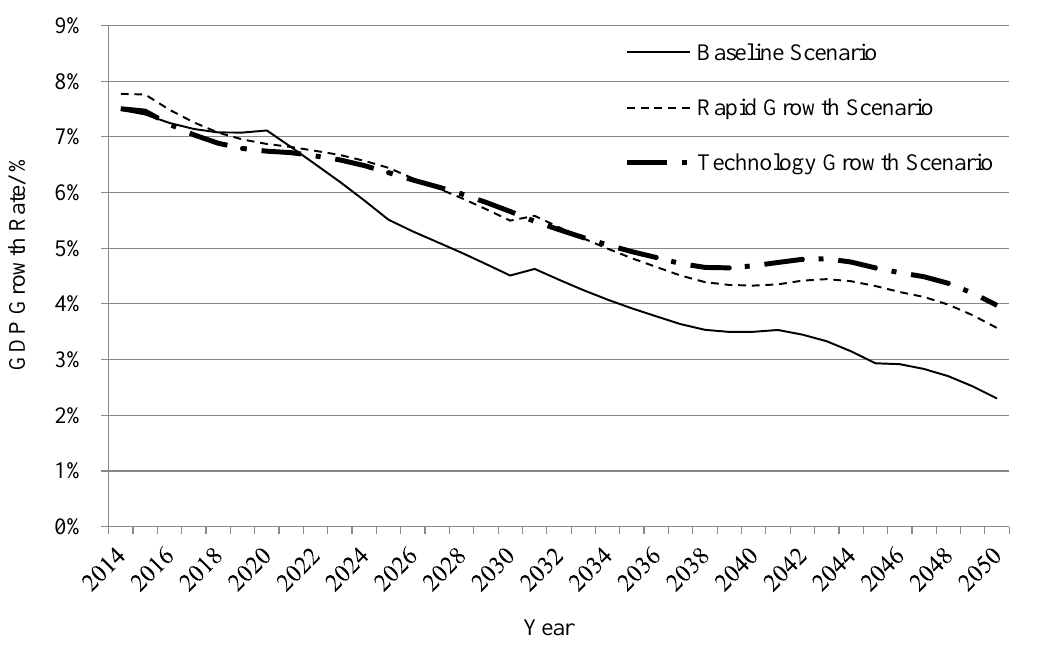
Figure 12. Projected economic growth under different economic growth